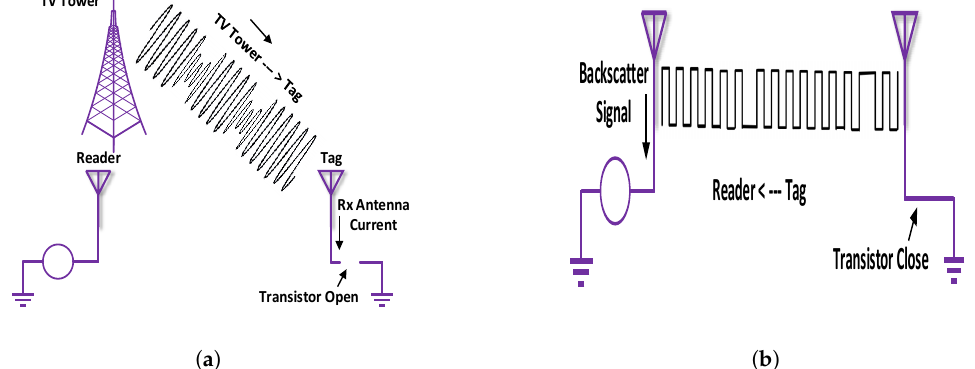
Figure 5. Basics of BackCom. ( a ) Signal from reader to tag; ( b ) signal from tag to